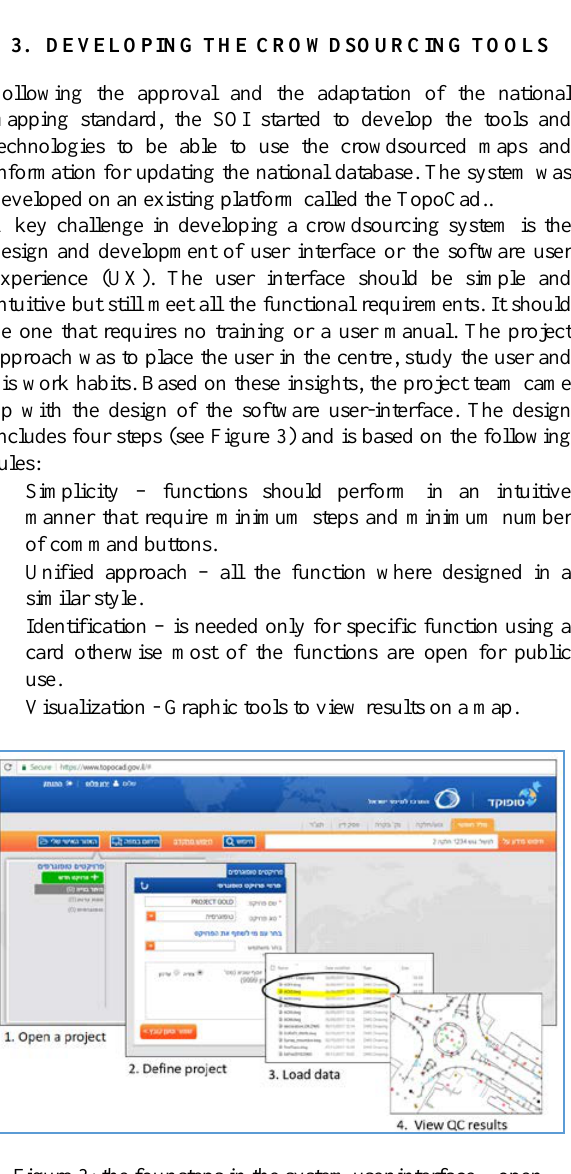
Figure 3: the four steps in the system user interface – open, define, load data, view QC